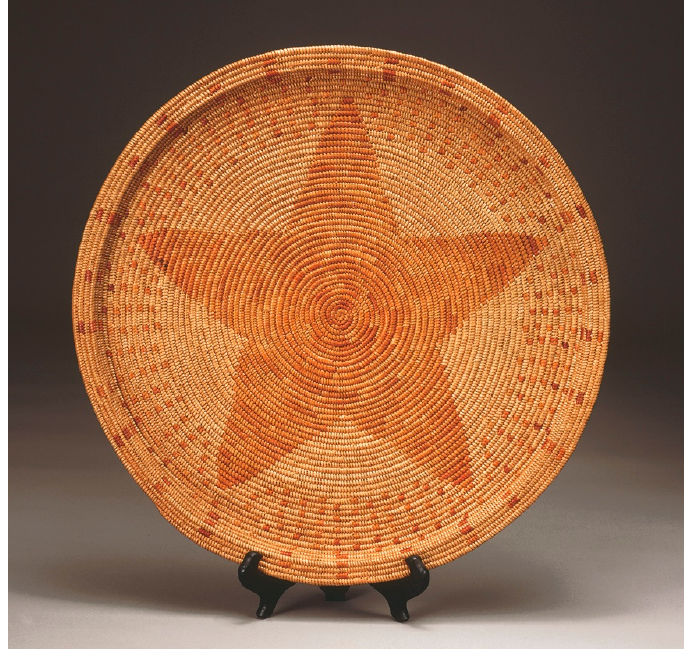
Figure 1. “Ramona” star tray, Ramona Lubo (Mountain Cahuilla, c. 1847–1922), 1906, grass, sumac, juncus, diameter 15 ½ and height 5/8 inches. Gift of Catherine Marshall Gardiner, Collection of the